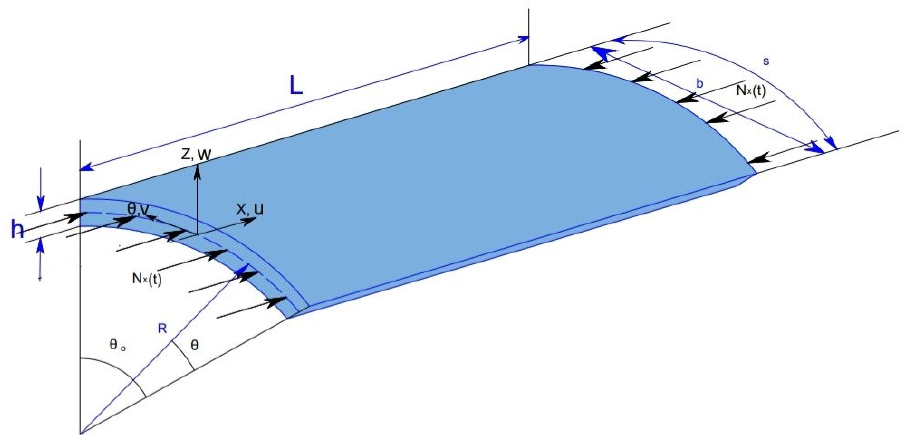
Figure 1. Geometric of the cylindrical panel under static and dynamic loads.